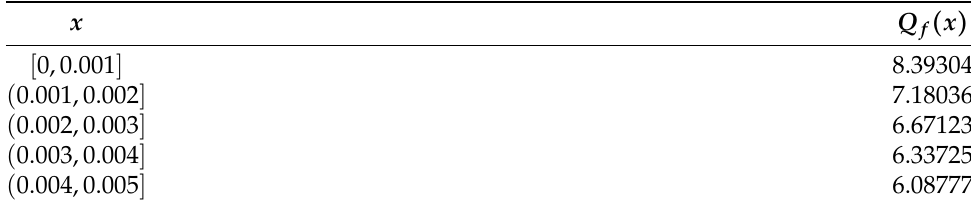
Table 2. The quantized values of the function Q f ( x ) in [ 0,0.005 ]